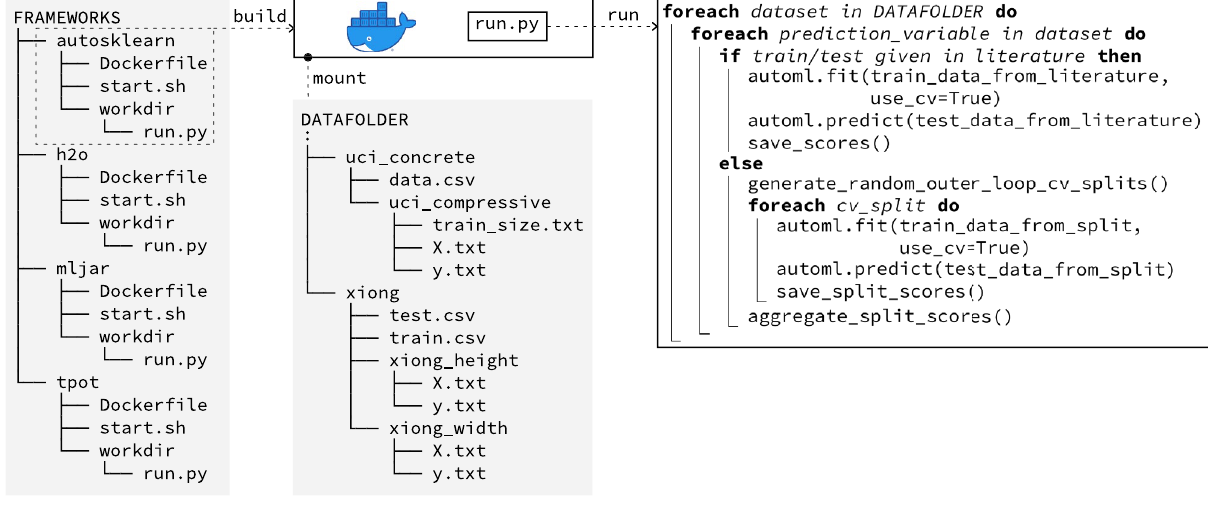
Figure 3. Workflow for the evaluation